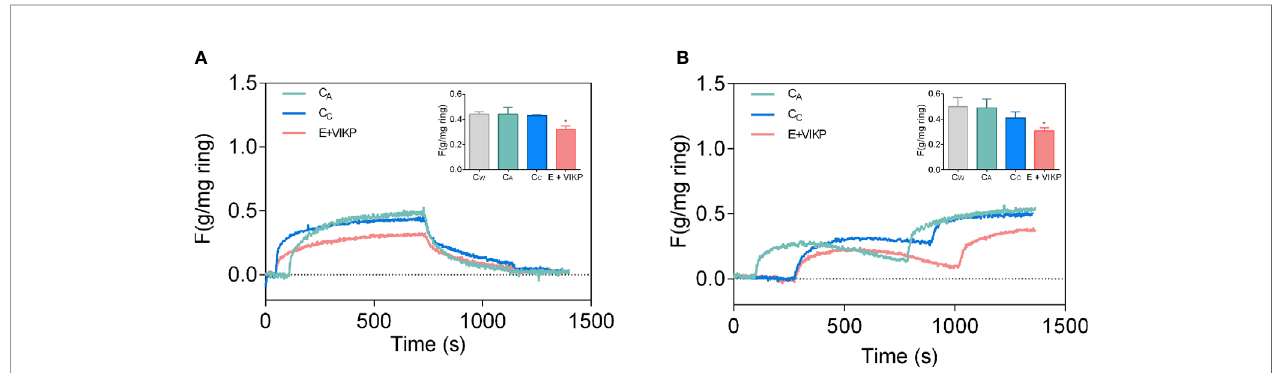
FIGURE 3 | Effect of different samples on contractile activity of isolated aortic rings as the strength per weight of the ring (gF/mg) contracted by exposure to potassium (A) and norepinephrine (B) . Rings extracted from animals treated with emulsion added with VIKP (E+VIKP), captopril (CC) aliskiren (CA) and water